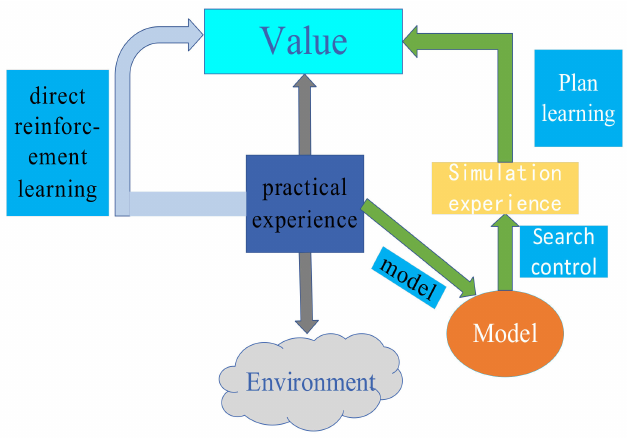
Figure 3. Structure diagram of